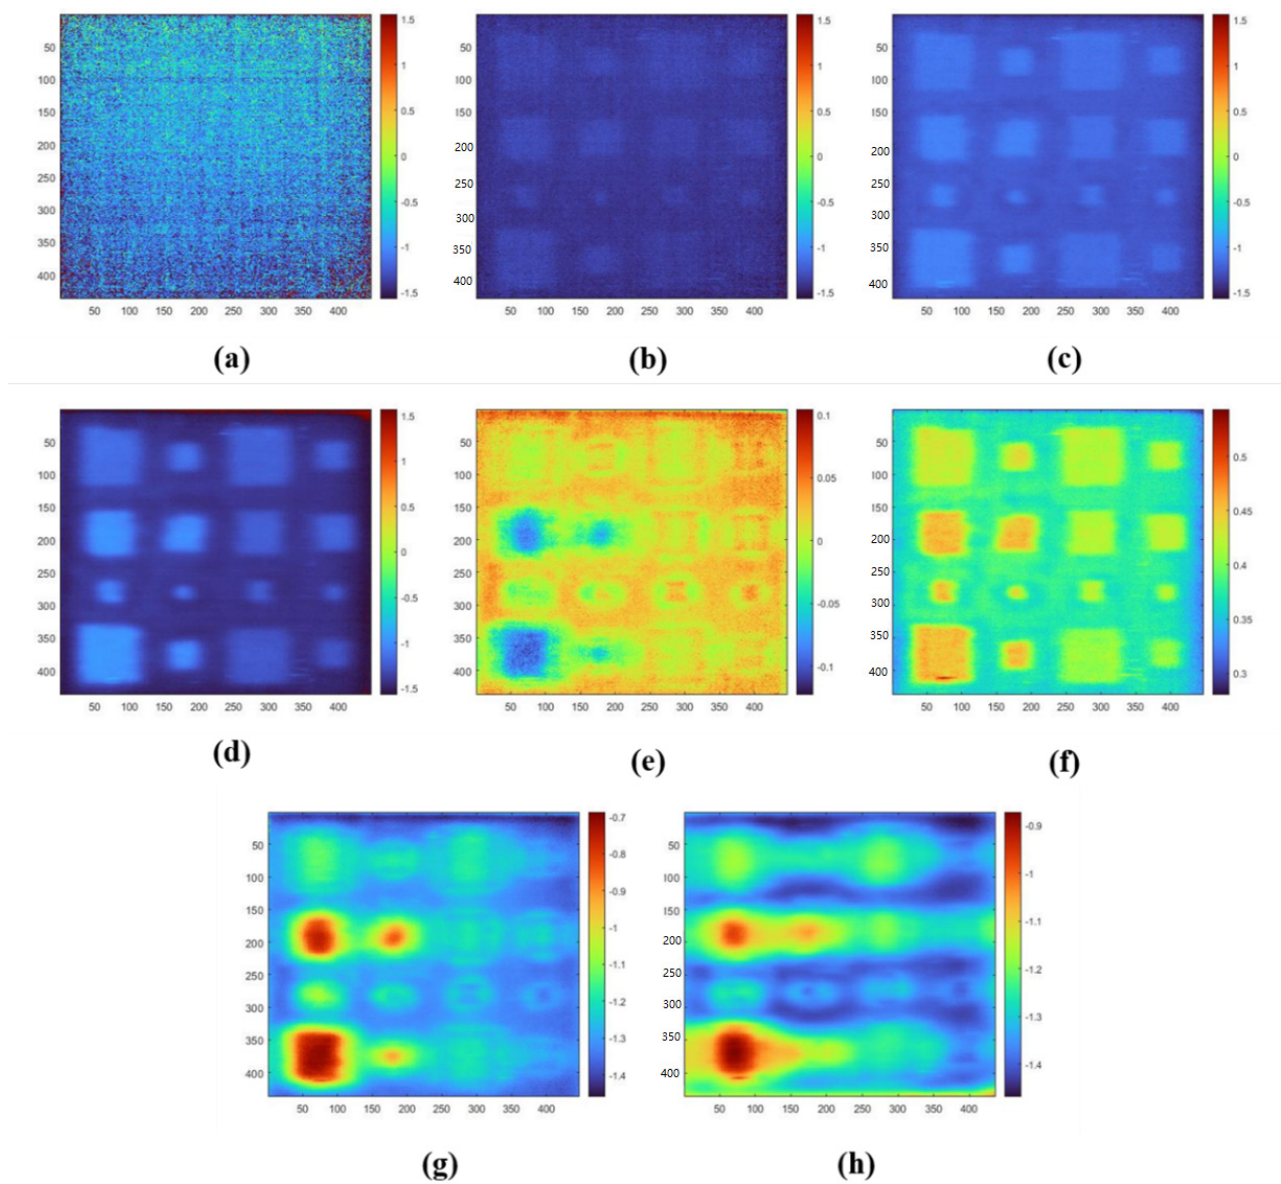
Figure 5. Phase images by the four-point method: ( a ) 1 Hz, ( b ) 0.5 Hz, ( c ) 0.2 Hz, ( d ) 0.1 Hz, ( e ) 0.07 Hz, ( f ) 0.05 Hz, ( g ) 0.03 Hz, ( h ) 0.01 Hz.